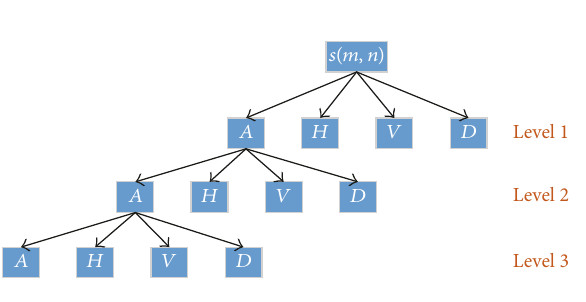
Figure 2: Pipeline of 2D-DWT.